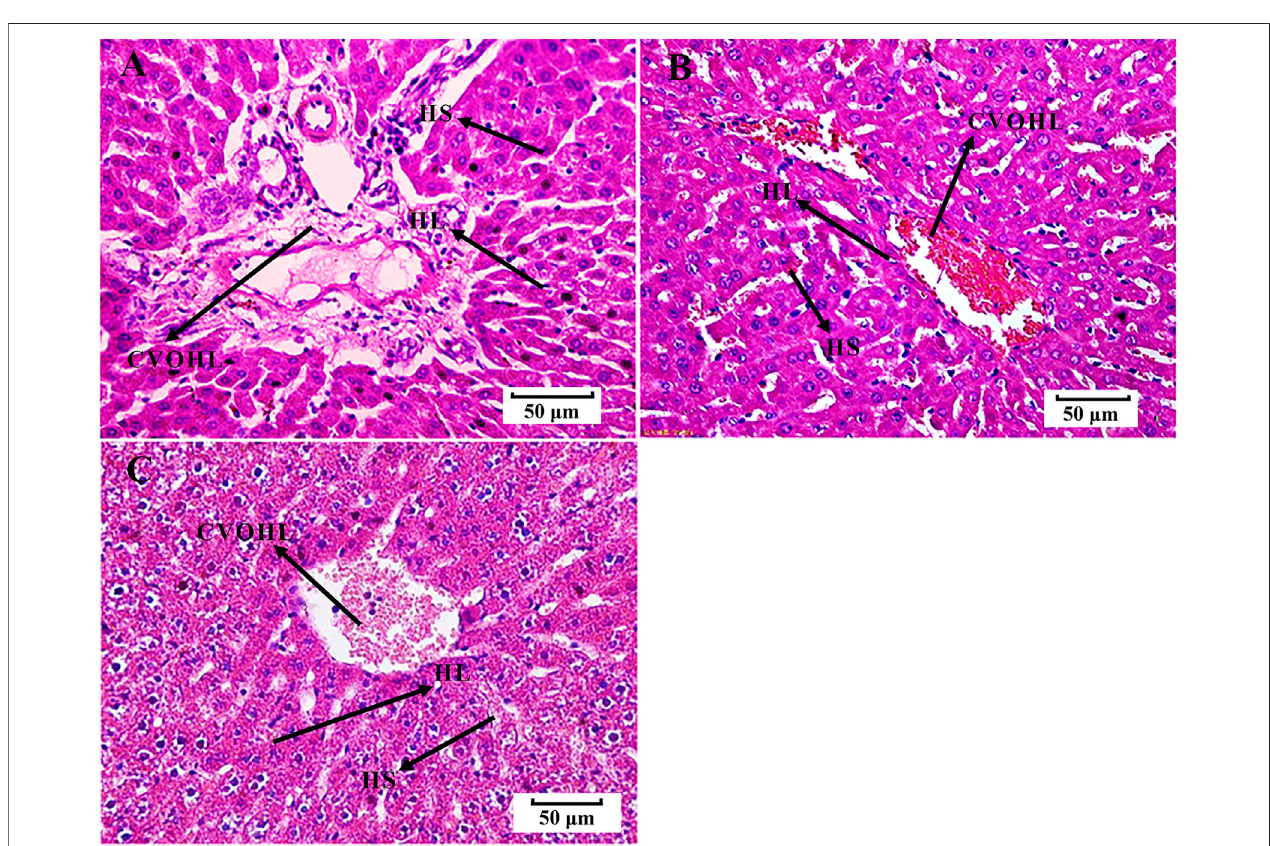
FIGURE 2 | Histological examination of liver tissues (H-E, 50 μ m). (A) control group B. (B) BS group. (C) PRR-treated group B. HS, hepatic sinus; CVOHL, central vein of hepatic lobules; HL, hepatic lobules.